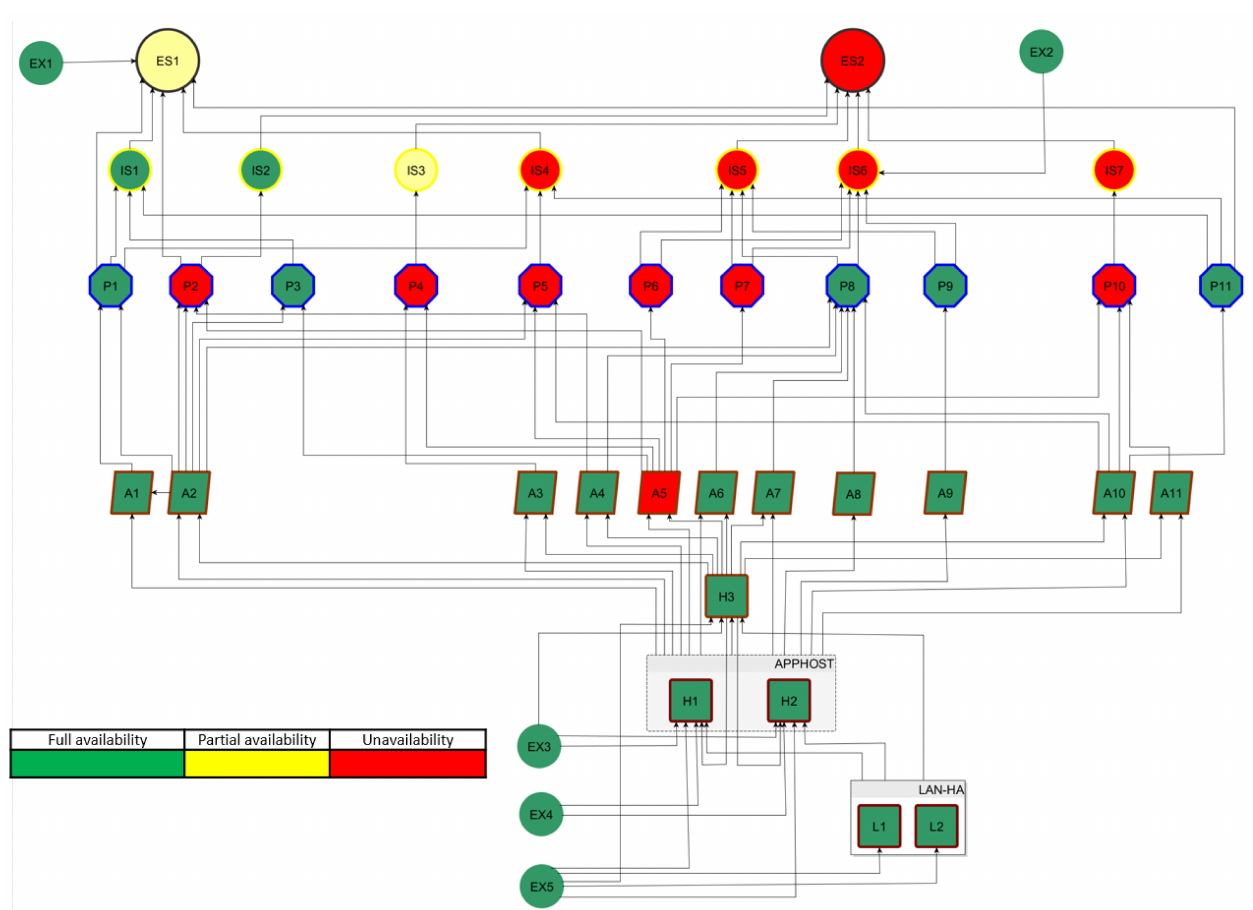
Figure 11. Object availability at time t = 4